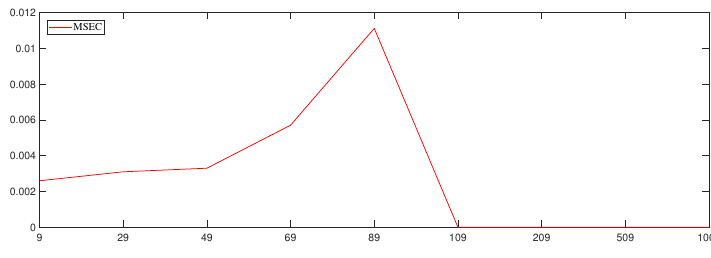
Figure 3. Folding line plot of the mean square error for a variance of